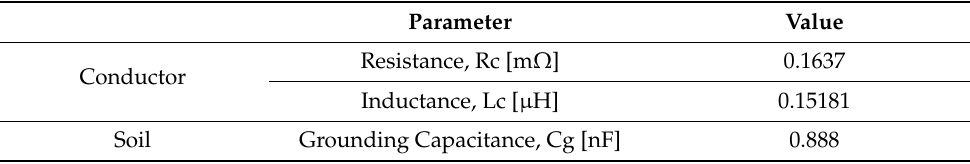
Table 2. Parameters of vertical rod and soil in the ATPdraw